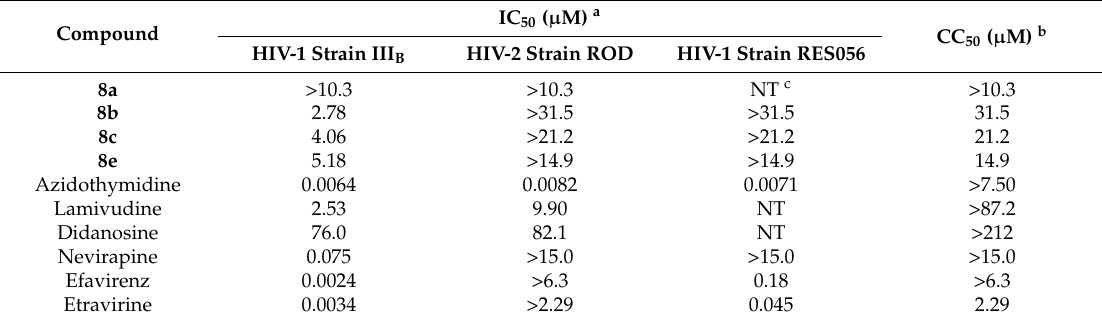
Table 3. In vitro anti-HIV activity and cytotoxicity of triazole derivatives of dihydroartemisinin.